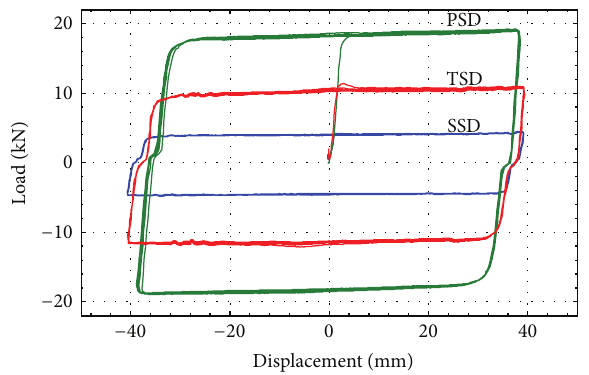
Figure 4: Load-displacement hysteresis curve (loading velocity = 5 mm/sec).